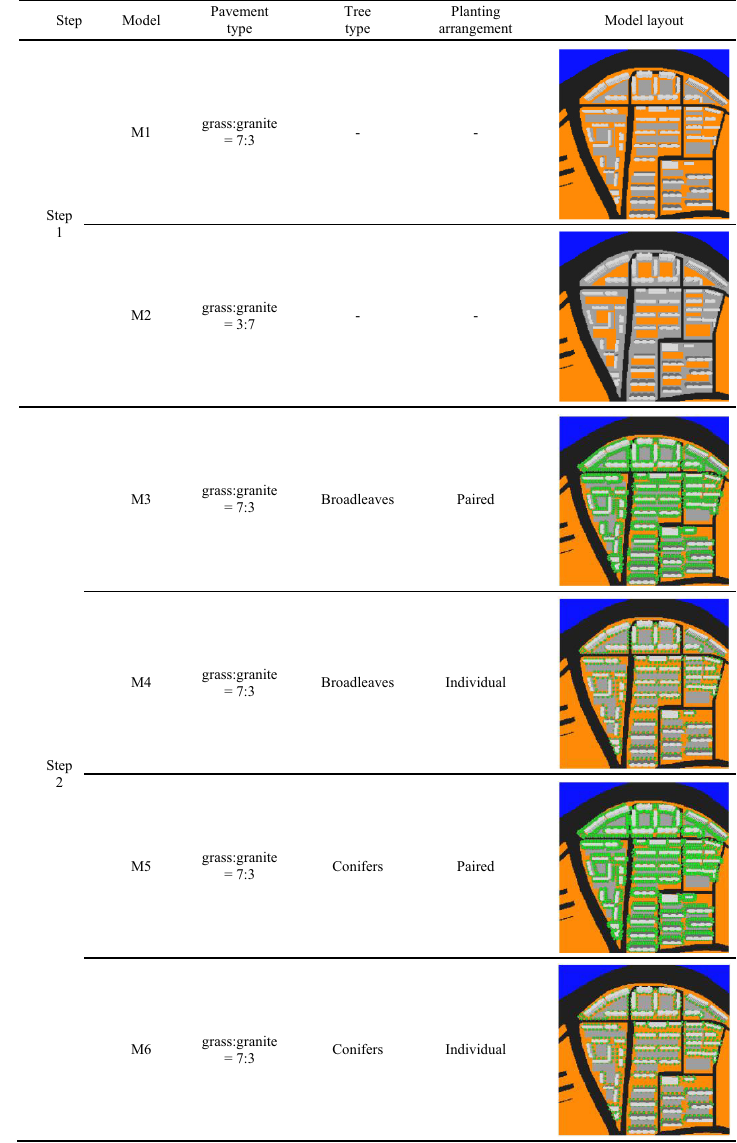
Figure 2. Six ENVI-met models for Apgujeong apartment complexNotes: Orange color indicates grass, whereas gray color indicates